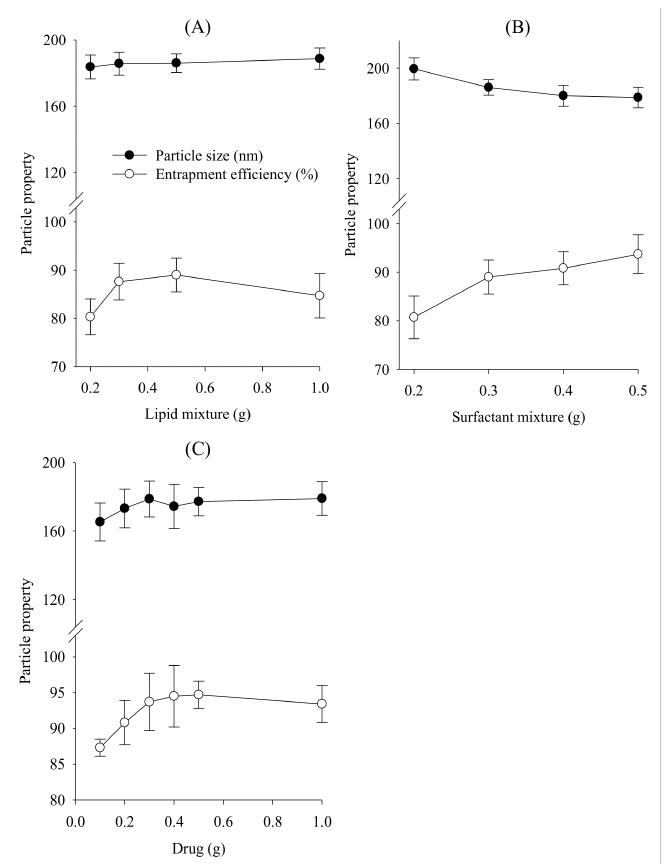
Figure 2. Effect of composites on the particle size and entrapment efficiency of SLN: ( A ) lipid mixture; ( B ) combined surfactants; ( C ) drug. Each value represents the mean ± S.D. ( n =